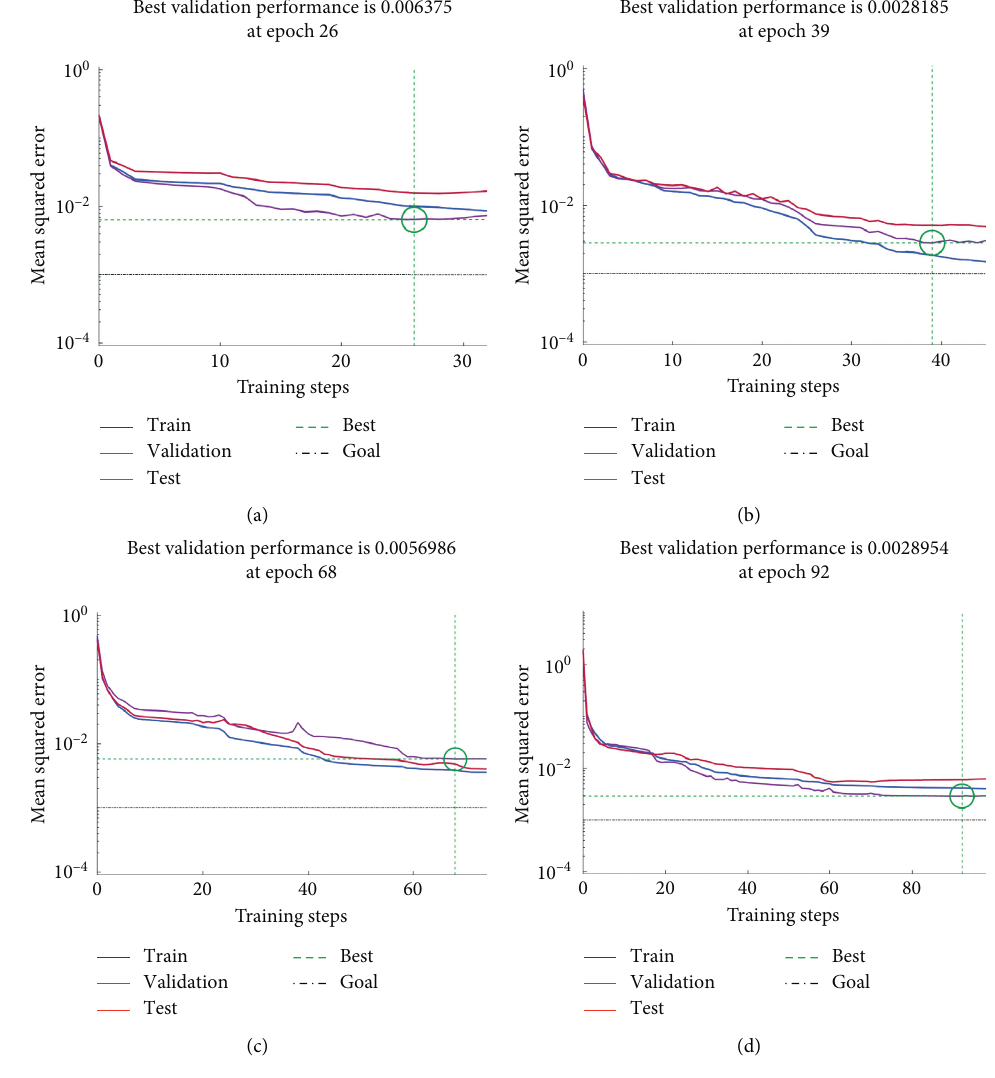
Figure 9: Comparison of each model’s convergence. (a) Improved HPSO-BP; (b) PSO-BP; (c) GA-BP; (d)